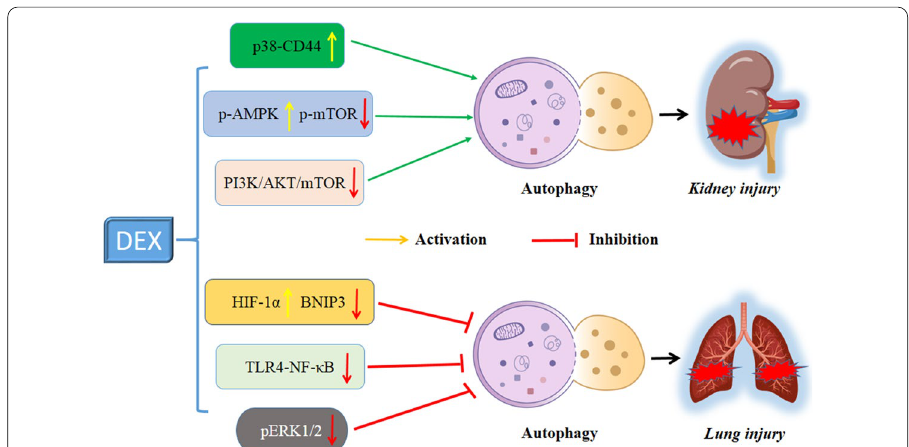
Fig. 3 Mechanisms of autophagy in kidney- and lung-protective effects of DEX. MAPK mitogen-activated protein kinase, AMPK adenosine monophosphate-activated protein kinase, HIF-1α hypoxia